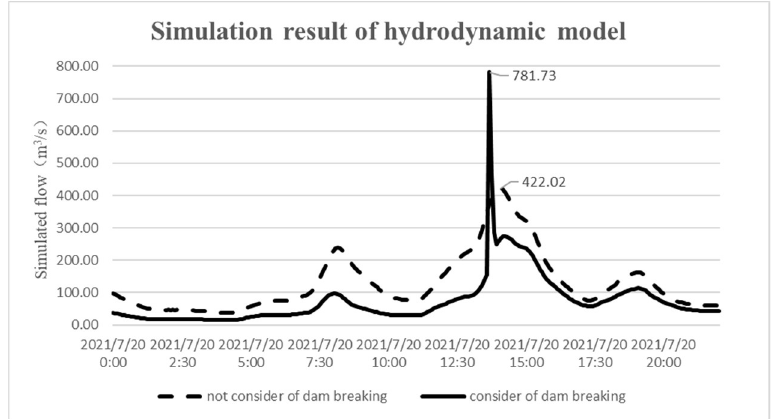
Figure 9. Hydrodynamic model simulation results.